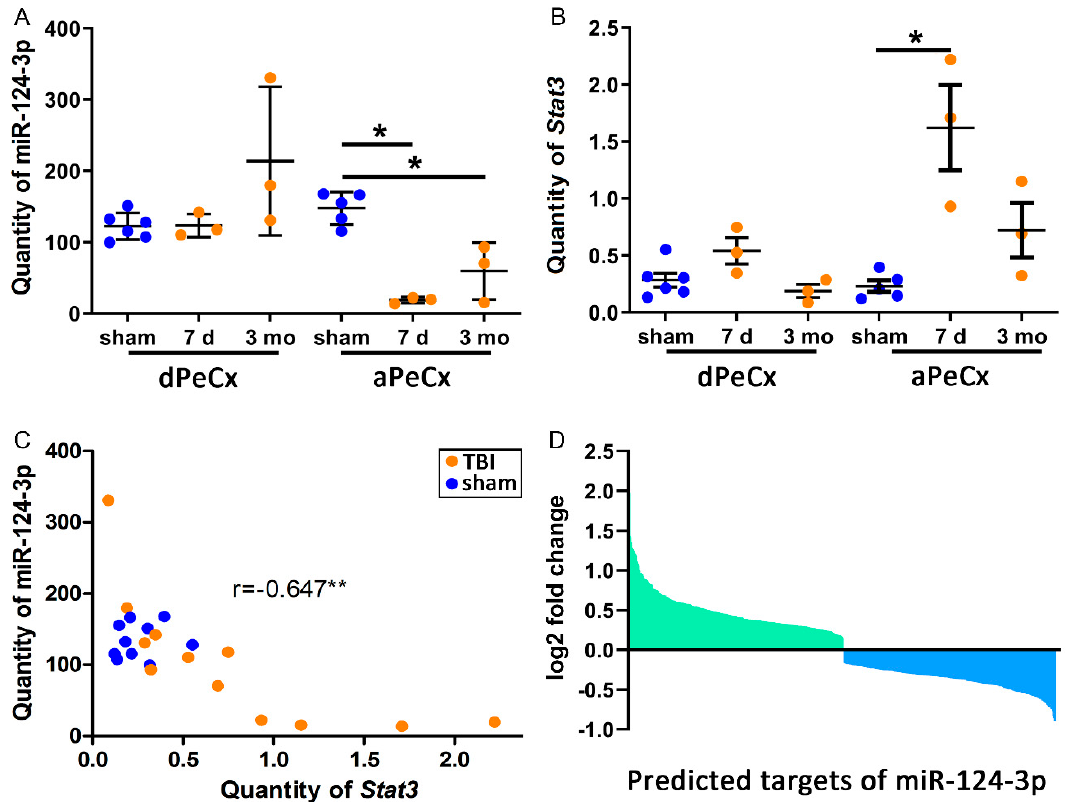
Figure 2. TBI downregulates miR-124-3p and upregulates Stat3 in the perilesional cortex. ( A ) A RT-qPCR analysis of laser-capture microdissected cortex indicated a downregulation of miR-124-3p in the perilesional cortex adjacent to the lesion core (aPeCx, FC 0.13 at 7 d, FC 0.40 at 3 months; both p < 0.05) but not in the more distal perilesional cortex (dPeCx, approximately 600 µm more dorsal) at both 7 d and 3 months post-TBI. ( B ) Expression of Stat3 , one of the targets of miR-124-3p, was upregulated in aPeCx at 7 d post-TBI ( p < 0.05, FC = 6.97) and tended to be upregulated at 3 months post-TBI ( p > 0.05, FC = 3.11). ( C ) A correlation analysis revealed that the higher the miR-124-3p levels, the lower the Stat3 levels (r = − 0.647, p < 0.01). ( D ) RNA sequencing revealed 312 upregulated and 311 downregulated targets of miR-124-3p. The gene set enrichment analysis (GSEA) of these targets indicated that only the downregulated targets were enriched in the dataset (ES = − 0.33, FDR < 0.01). dPeCx, distal part of cortex; d, day; ES, enrichment score; FC, fold change; FDR, false discovery rate; LCM, Laser capture microdissection; mo, month; aPeCx, perilesional cortex; RT-qPCR, quantitative reverse transcriptase polymerase chain reaction. Statistical significance: * p < 0.05, ** p < 0.01 (Mann–Whitney U).